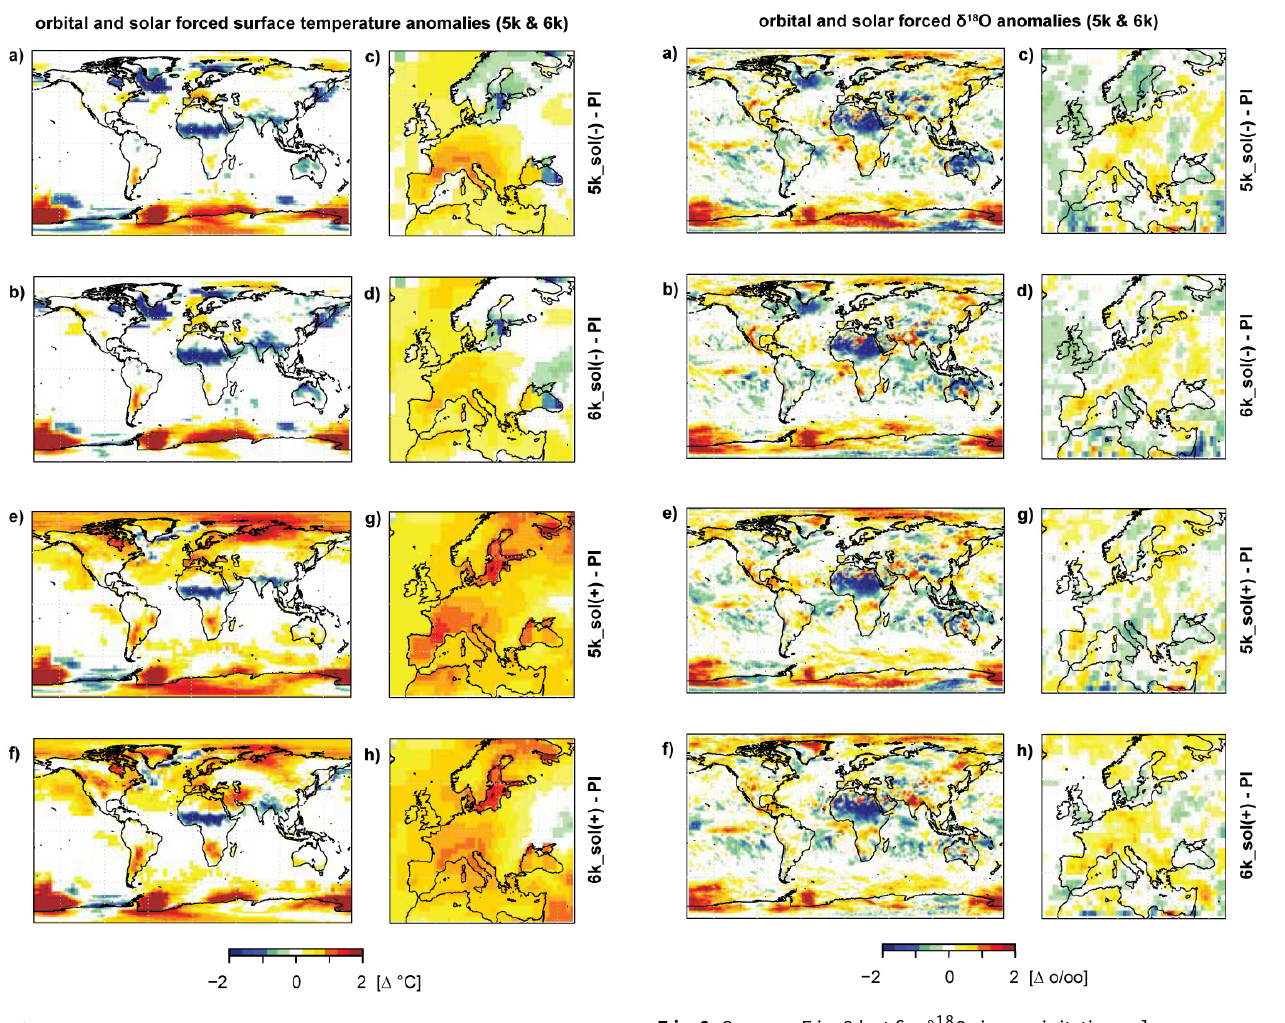
Fig. 8. Same as Fig. 6 but for the combined effect of orbital-driven insolation and solar activity changes.